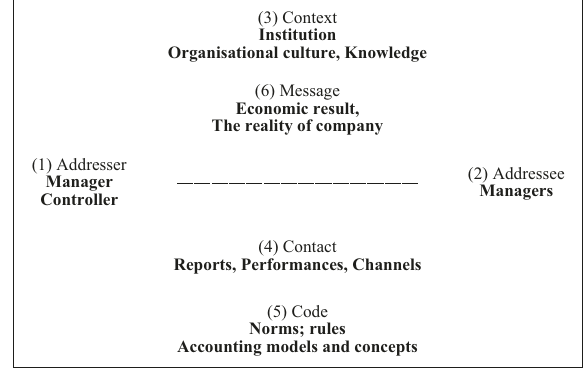
Fig. 4 Communication model in Pärl (2012a). Source: Partially modi fi ed from Pärl (2012a, p. 104).